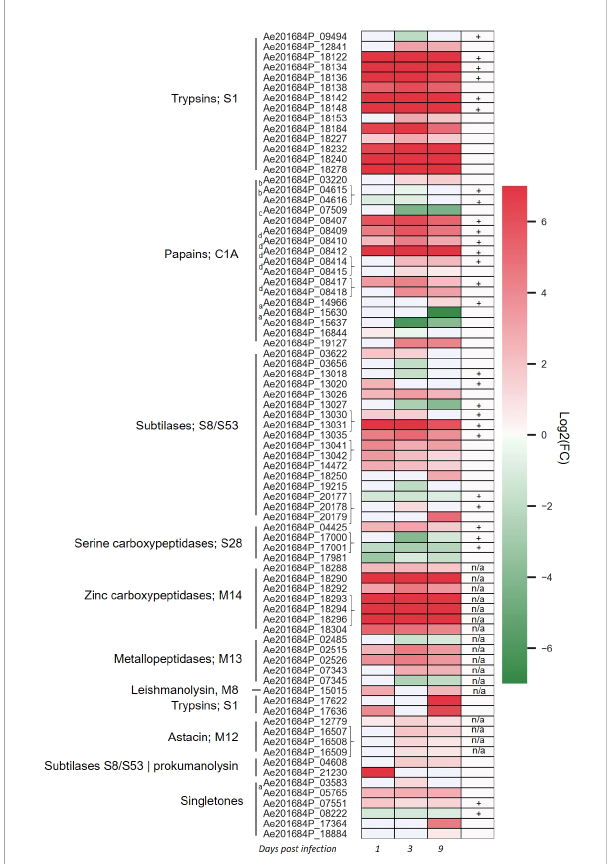
FIGURE 2 Aphanomyces euteiches differentially expressed genes coding for secreted proteases during Medicago truncatula infection. Three fi rst columns of the heatmap represents log2(Fold Change) value of the signi fi cantly differentially expressed genes (DEG, p-value <0.05) during the time course of infection of M. truncatula roots (1, 3, 9 days post infection) as compared to the free-living mycelium. Braces on the right side of the gene name indicate adjacent tandemly repeated genes. The fourth column represents the identi fi cation of secreted proteases in activity-based proteome pro fi ling proteomics (ABPP-MS) experiment using probes against active serine and cysteine hydrolases (+: identi fi ed by proteomics, blank: not identi fi ed by proteomics, n/a: probe not adapted for proteomics detection). Letter on the left side of the gene name indicate the presence of a binding domain within the secreted proteases [a: PAN/Apple domain (PF14295), b: ML domain (PF02221), c: fungal cellulose binding domain (PF00734), d: cysteine rich secretory domain CAP